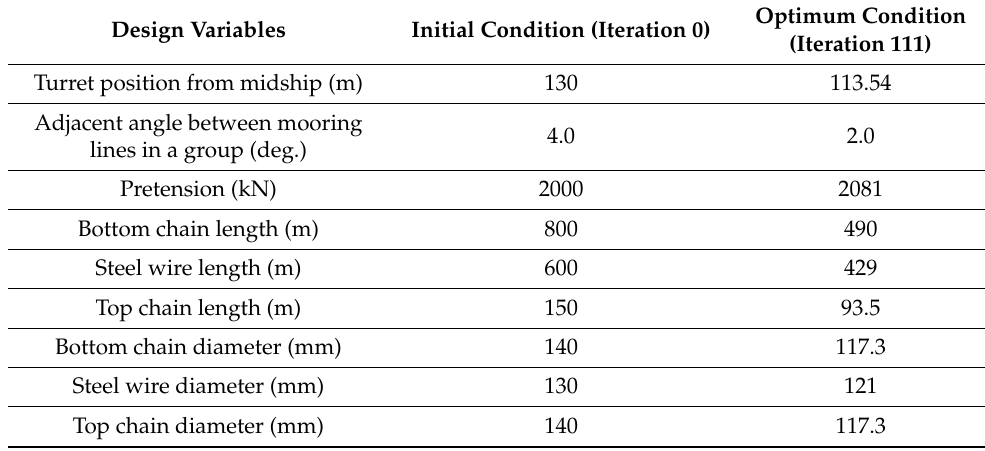
Table 12. The constraint results for case C.